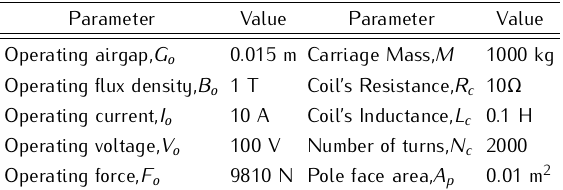
Table 1. Parameters of the EMS